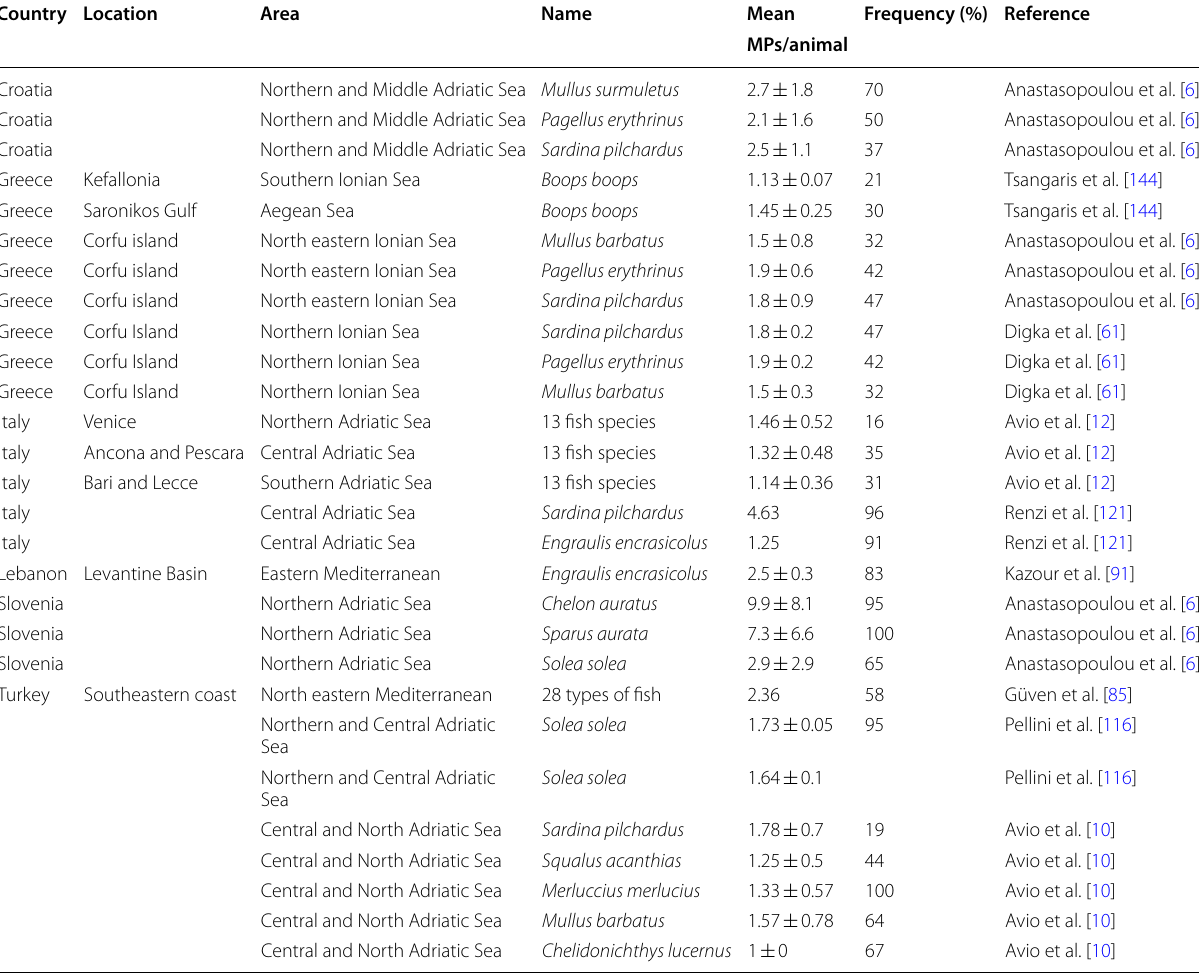
Table 9 A summary of the number of MP items found in fish around the eastern Mediterranean basin Country